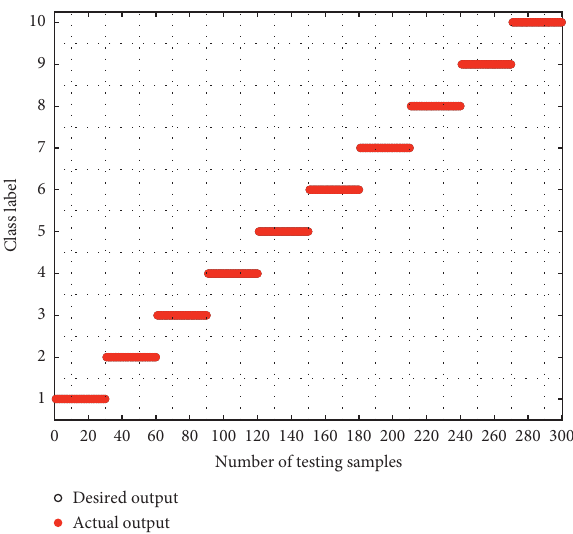
Figure 8: The fault identification results of the presented